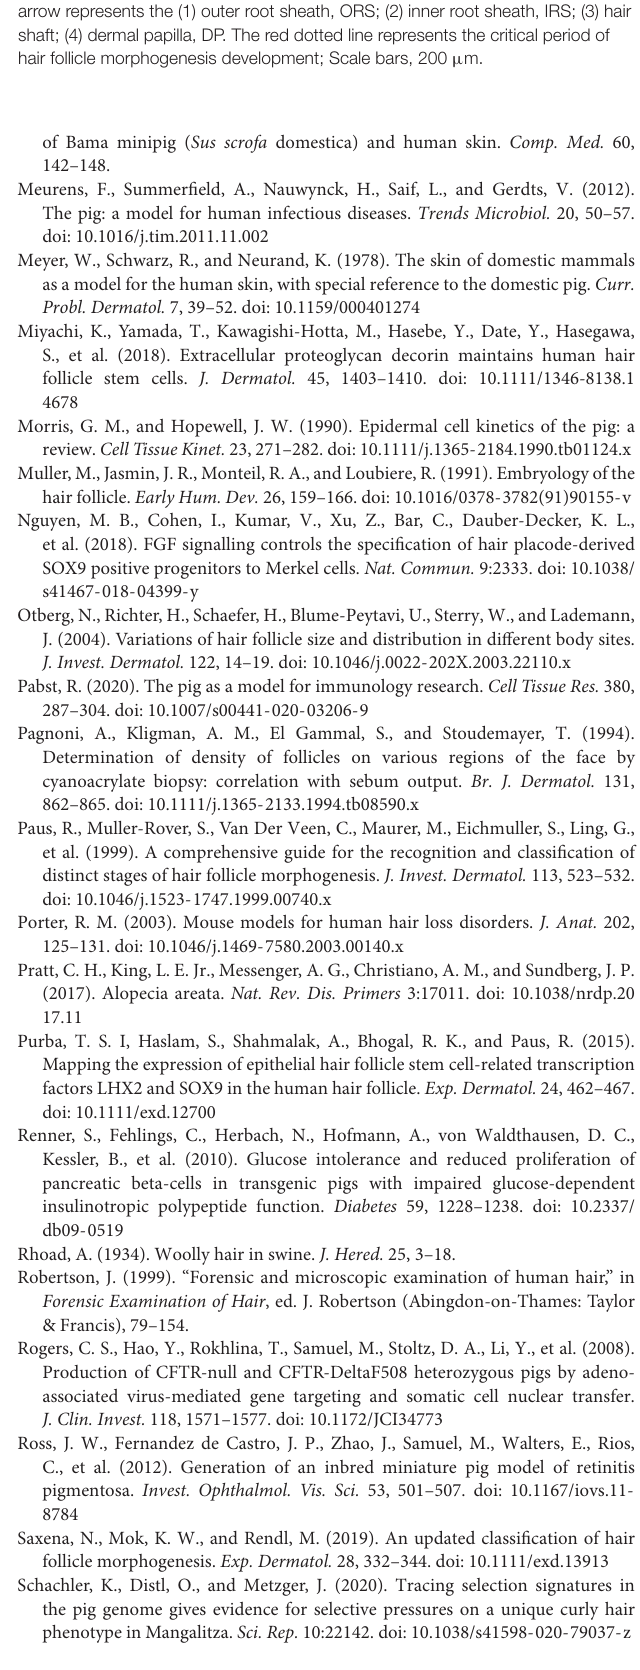
Supplementary Figure 2 | H&E staining of Hair follicle morphogenesis at 11 different prenatal and six postnatal times (E37–P45). The red arrow represents the hair placode and hair germ. The green arrow represents the hair peg. The Blue